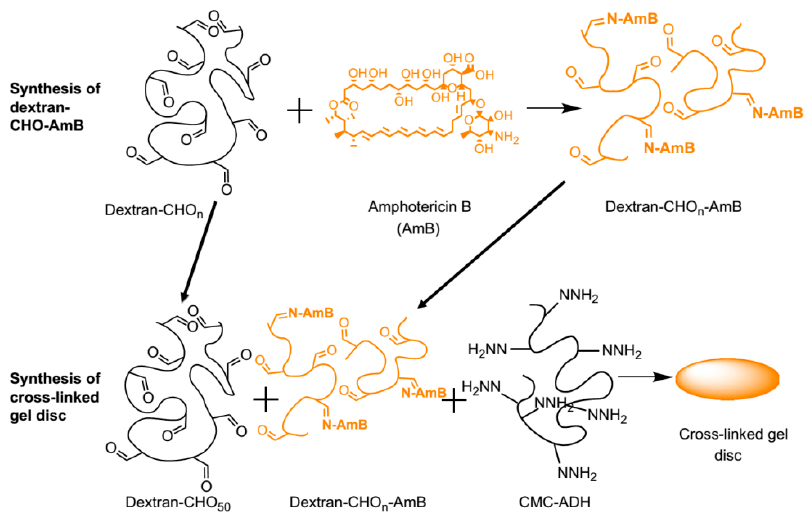
Figure 10. Conjugation of amphotericin B (AmB) to oxidized dextran and the incorporation of the dextran-CHO-AmB into a carboxymethylcellulose (CMC)-dextran gel. Reproduced with permission from ref. [29].